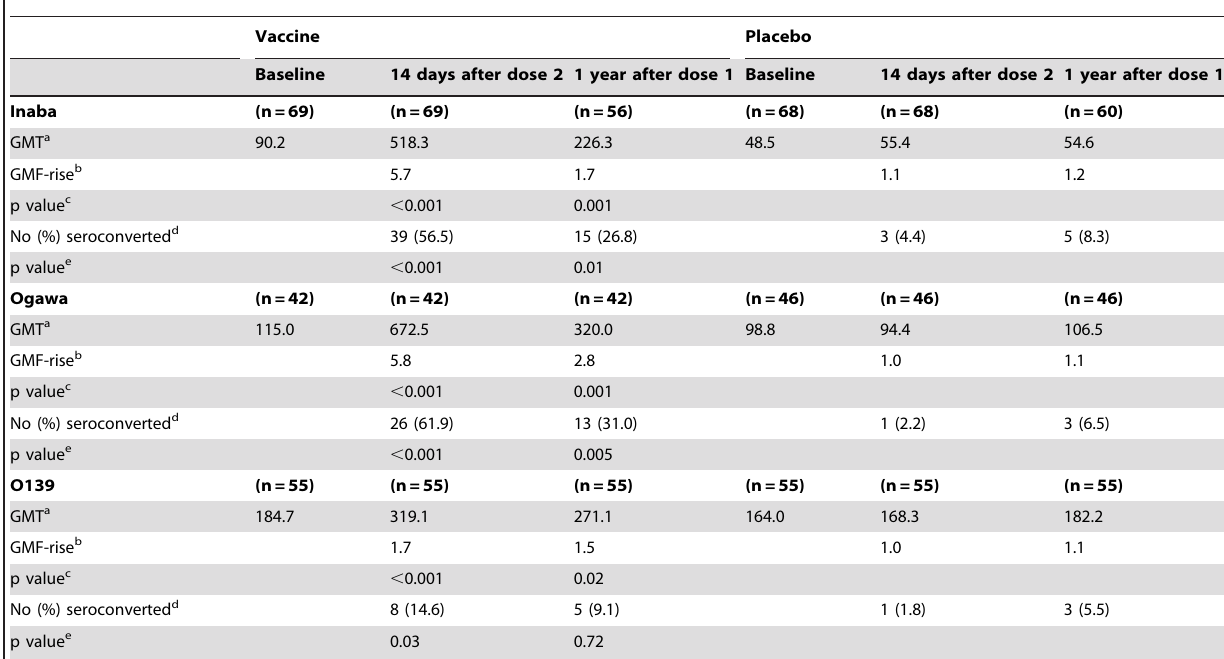
Table 1. Serum vibriocidal antibody titers to V. cholerae O1 Inaba among vaccine and placebo recipients.